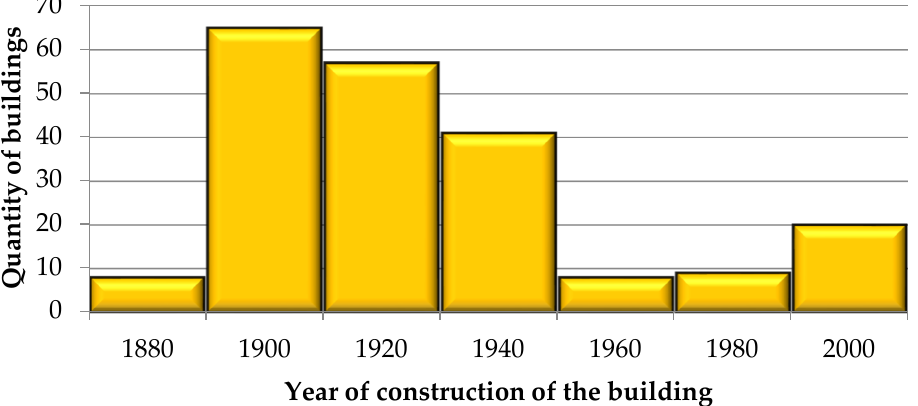
Figure 6. Distribution of data for the variable relating to the year of construction of buildings.